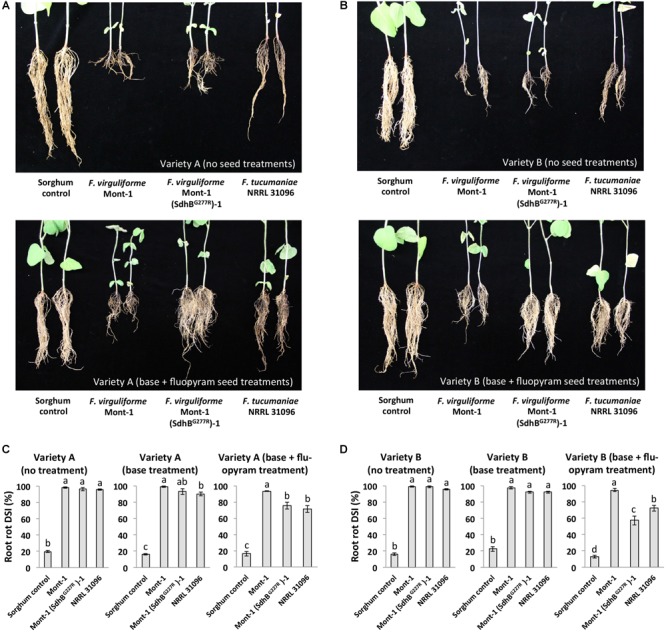
Root rot caused by F. virguliforme strains Mont-1 and Mont-1(SdhBG277R)-1 and F. tucumaniae strains NRRL 31096 without and with fluopyram. (A) The picture of soybean root rot from variety A with no treatment and with base + fluopyram treatment infected by strains Mont-1, Mont-1(SdhBG277R)-1, NRRL 31096, and sorghum control 28 days after inoculation. (B) The picture of soybean root rot from variety A with no treatment and with base + fluopyram treatment infected by strains Mont-1, Mont-1(SdhBG277R)-1, NRRL 31096, and sorghum control 28 days after inoculation. (C) Root rot disease severity index (DSI) on soybean variety A with no treatment, base treatment, and base + fluopyram treatment infected by three Fusarium strains. Means followed by the same letter are not significantly different (P < 0.05) using Fisher’s Protected Least Significant Difference test. (D) Root rot disease severity index (DSI) on soybean variety B with no treatment, base treatment, and base + fluopyram treatment infected by three Fusarium strains. Means followed by the same letter are not significantly different (P < 0.05) using Fisher’s Protected Least Significant Difference test.